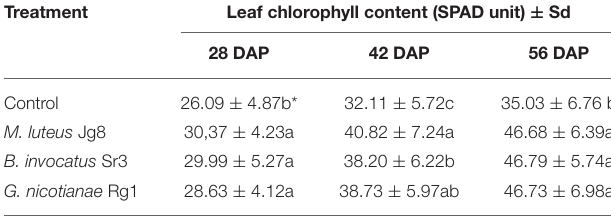
TABLE 7 | Effect of rhizobacteria to the leaf chlorophyll content of corn cultivar Pertiwi at 28, 42, and 56 days after planting (DAP). Treatment